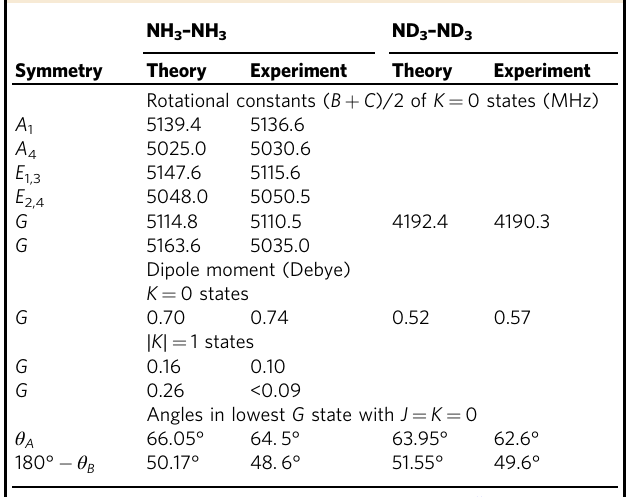
Table 1 Comparison of calculated properties of NH 3 – NH 3 and ND 3 – ND 3 with the available experimental data 7,8,11,36